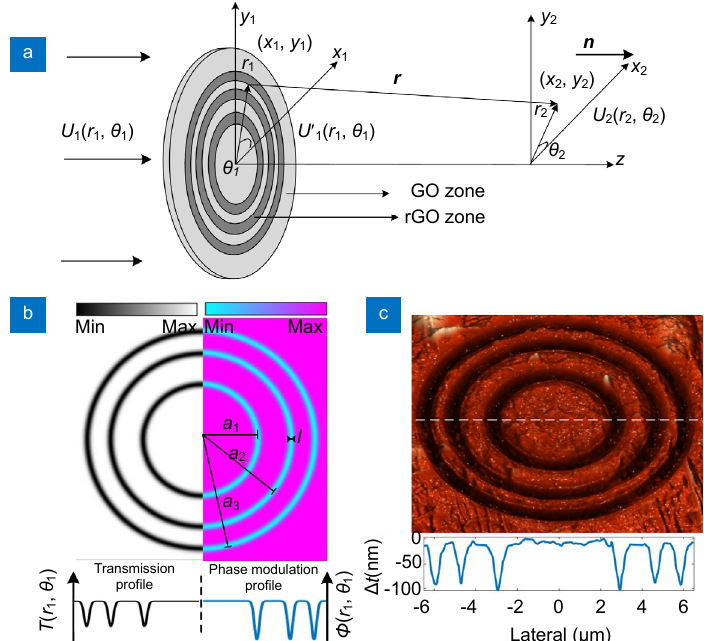
Fig. 1 | The design of the GO ultrathin flat lens . ( a ) Diffraction of GO ultrathin flat lens in polar and Cartesian coordinate systems. ( b ) Transmission and phase modulations provided by the GO lens. ( c ) Topographic profile of the GO ultrathin flat lens measured by an atomic force